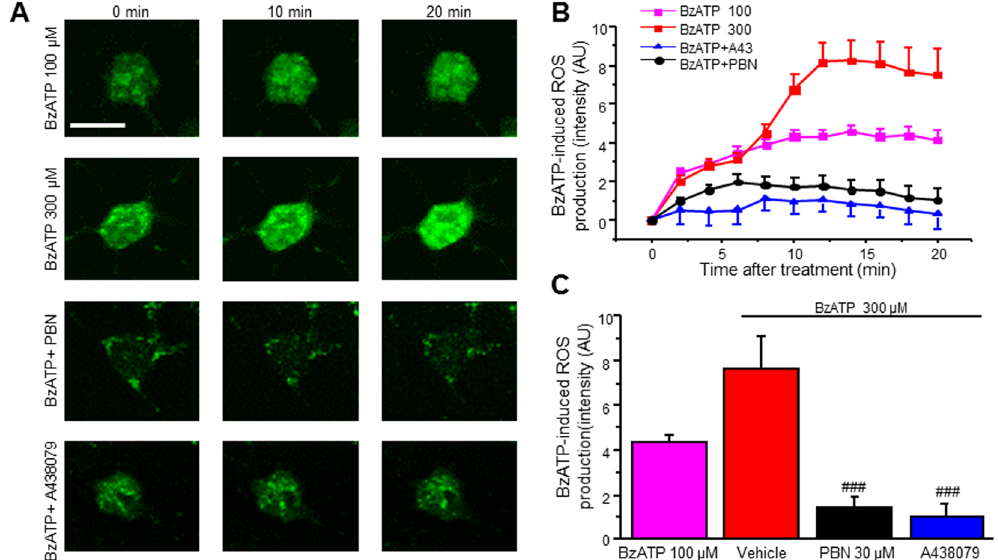
Figure 2. P2X7R activation with BzATP induces ROS production in SCDH neurons. ( A ) Representative of live cell confocal images captured before (0 min) and after application of BzATP in the presence of vehicle, PBN